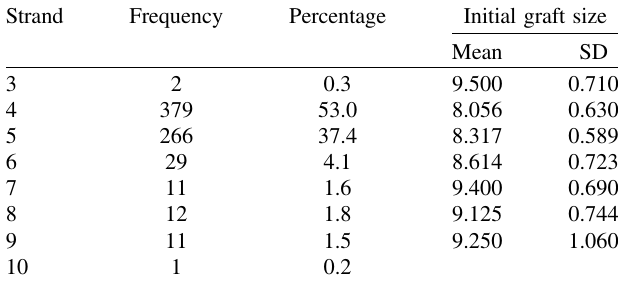
Table 3. Number of strands, their frequency and percentage distribution, and the mean initial graft size for different strand con fi gurations.